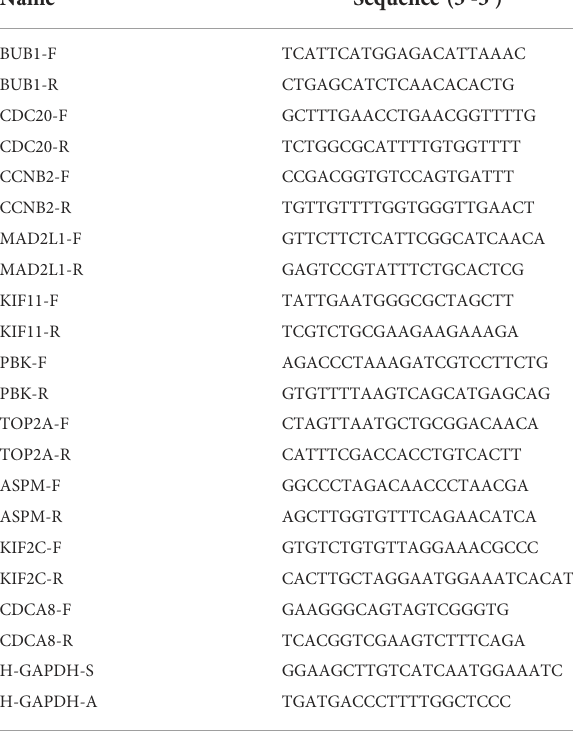
TABLE 2 Primers used for qRT-PCR.